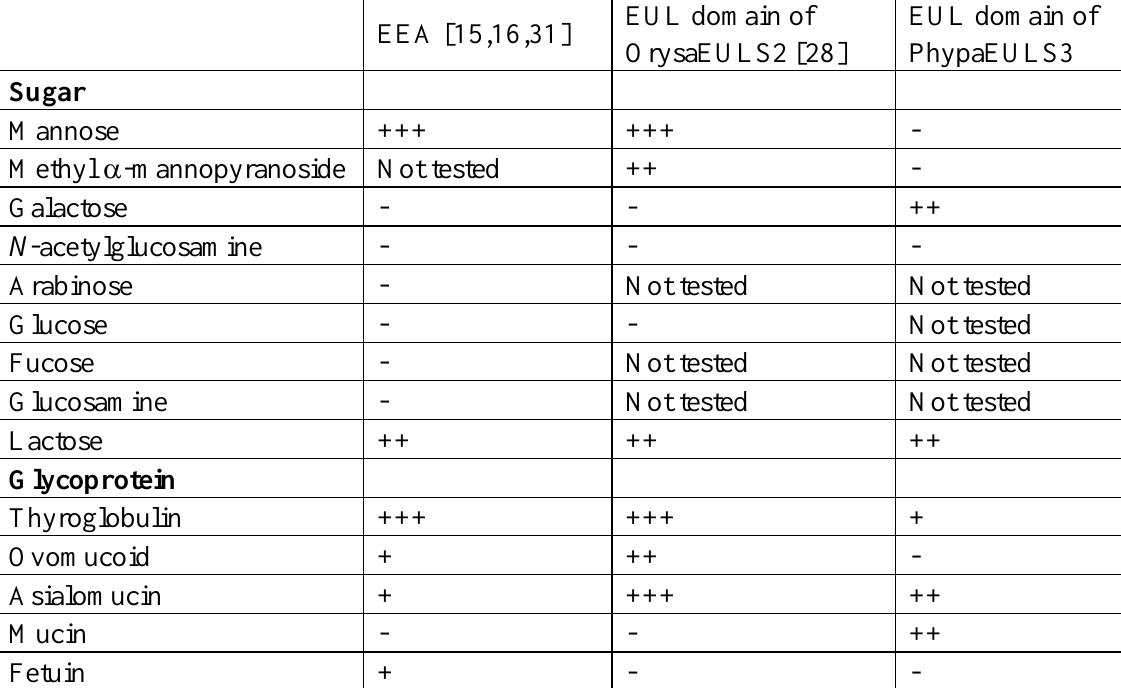
Table 1. Carbohydrate-binding specificity of EEA, the EUL domain of OrysaEULS2 and the EUL domain of PhypaEULS3 determined by agglutination inhibition assays with different sugars or glycoproteins. - : no inhibition of agglutination; + weak inhibition of agglutination; ++ strong inhibition of agglutination; +++ very strong inhibition of